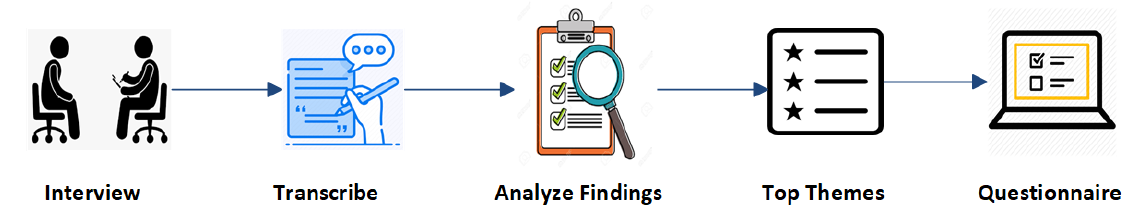
Figure 1. Steps Followed in Survey Questionnaire